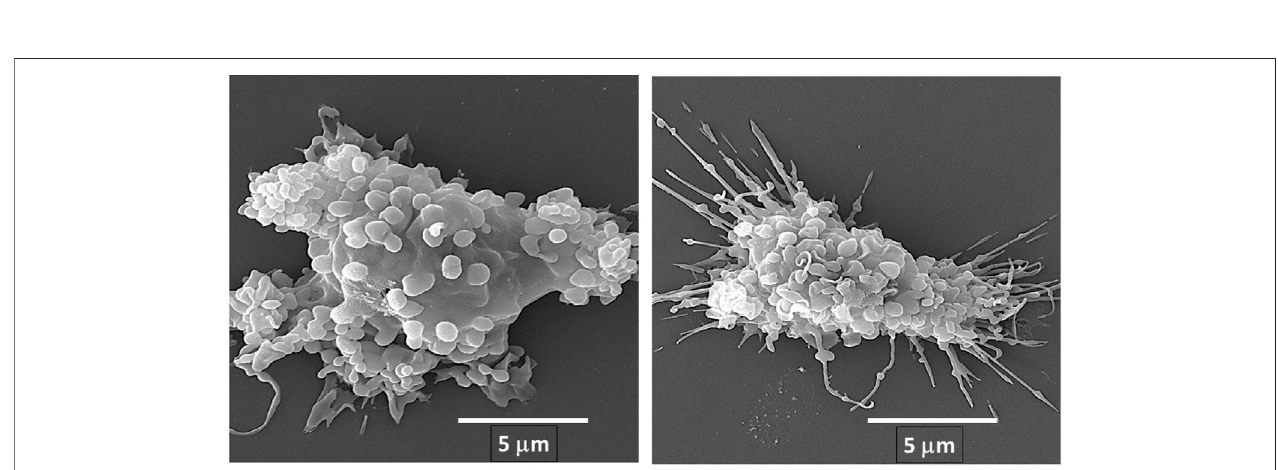
FIGURE 8 | Fc/Fc γ receptor interaction between anti-Gal/ α -gal nanoparticle immune-complexes and adherent α 1,3galactosyltransferase knockout (GT-KO) pig macrophages, as demonstrated by scanning electron microscopy (SEM). α -Gal nanoparticles were incubated with the macrophages for 2 h at room temperature and thenwashedtoremovenonadherentnanoparticlesandsubjectedtoSEManalysis.Theextensivebindingofthenanoparticlestomacrophagesresultsintheinductionof amorespherical,ratherthan fl atshapeofthetwomacrophagespresentedinthis fi gure.ReprintedfromGaliliU. Thenaturalanti-Galantibodyasfoeturnedfriendin medicine . Publishers Academic Press/Elsevier, London, 2018, with permission.